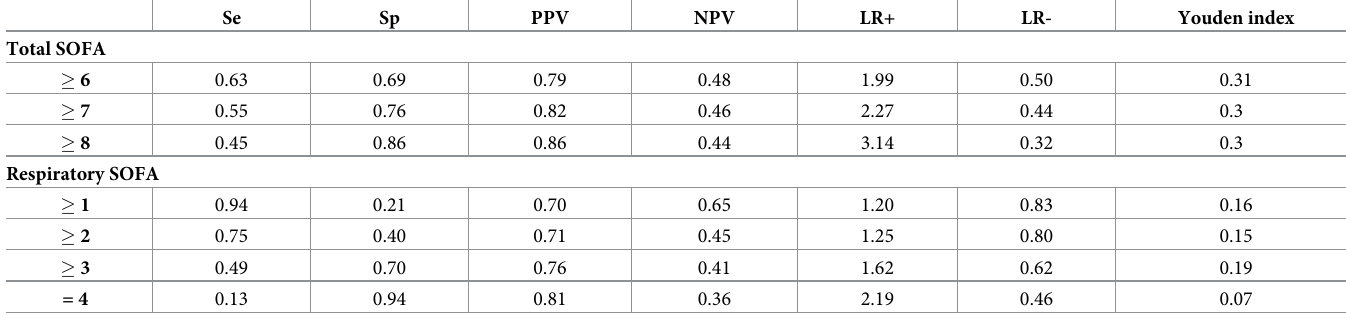
SOFA sequential organ failure assessment; Se sensitivity; Sp specificity; PPV positive predictive value; NPV negative predictive value; LR+ positive likelihood ratio; LR- negative likelihood ratio; VA-LRTI ventilator-associated lower respiratory tract infection; VAP ventilator-associated